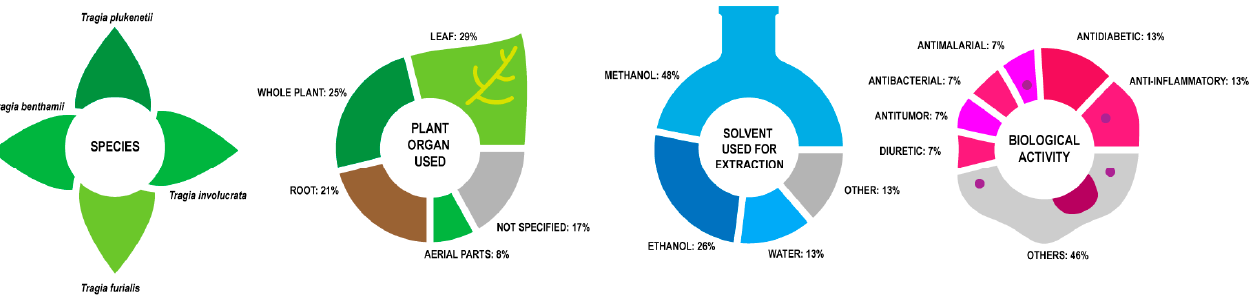
Figure 6. Summary of in vivo activity of Tragia extracts.